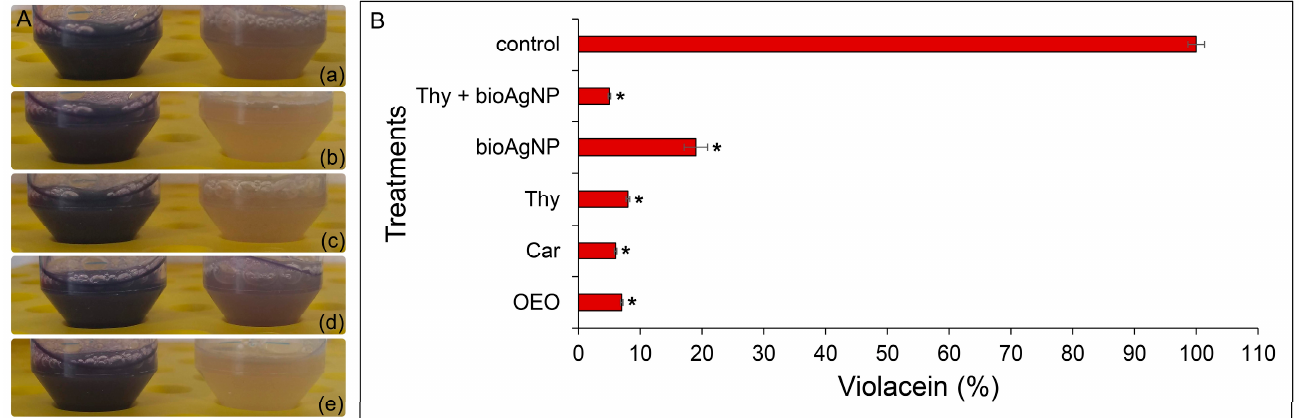
Figure 6 . E ff ect of oregano-derived antimicrobials and bioAgNP individually and in combination on violacein production by Chromobacterium violaceum . C. violaceum was exposed for 24 h to fi ve treatments at subinhibitory concentrations as follows: OEO at 0.07 mg/mL, Car at 0.04 mg/mL, Thy at 0.06 mg/mL, bioAgNP at 3.94 µg/mL, and combination composed of Thy at 0.008 mg/mL and bioAgNP at 0.49 µg/mL. ( A ) It shows the result of a qualitative analysis of the e ff ect of antimicrobials on violacein production by C. violaceum . The fi rst tube of each pair is untreated control, which shows high production of violacein pigment after 24 h of incubation at 28 °C. The second tube of each pair is C. violaceum treated with antibacterials at subinhibitory concentrations for 24 h as follows: ( a ) OEO-treated bacterial cells, ( b ) Car-treated bacterial sample, ( c ) Thy-treated bacterial sample, ( d ) bioAgNP-treated bacterial cells, and ( e ) bacterial cells treated with a combination of Thy plus bio- AgNP. The color intensity of violet indicates the amount of violacein pigment. The turbidity of the broth medium indicates that compounds reduced violacein production without a ff ecting bacterial growth. ( B ) It shows a quantitative analysis of the amount of violacein produced by C. violaceum treated with antimicrobials individually and in combination. Extracted violacein was measured at 595 nm. The amount of pigment produced by each treated bacterial sample is based on the amount produced by the untreated sample (control which produces 100% of pigment as determined). Amounts of violacein (%) are the mean ± standard deviation.* Indicates a statistically signi fi cant di ff erence ( p < 0.05, Kruskal–Wallis test) between treated and untreated control in terms of violacein production.